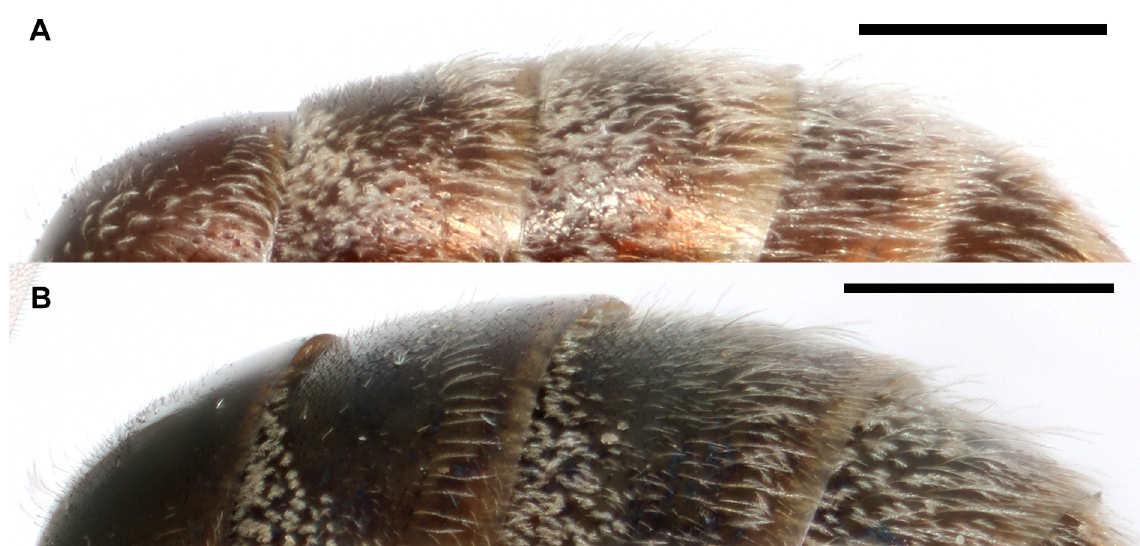
Fig. 85. Metasomal terga. A . Lasioglossum coactus (Cresson, 1872), ♀, with T2–T3 each slightly convex and apical rim downcurved in lateral view. B . L. tegulare (Robertson, 1890), ♀, with T2–T3 each flat and apical rim continuous with contour of disc in lateral view. Scale bars = 0.5 mm.